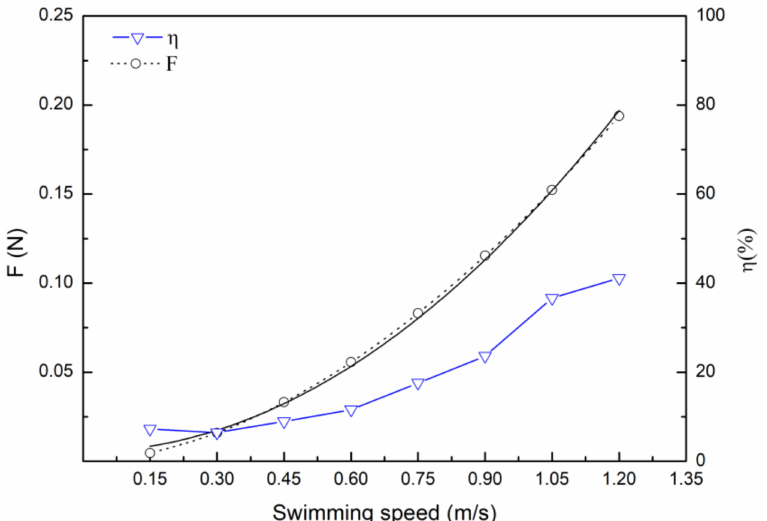
Figure 6. Drag, F , and efficiency, η , of crucian carp at different swimming speeds. Drag of fish ( F , mean) as function of swimming speed (Function: F = 0.0055 + 0.13 Us , R 2 = 0.998, p < 0.001, black solid line). Trend of F relative to Us (black dotted line). Trend of η relative to U s (blue solid